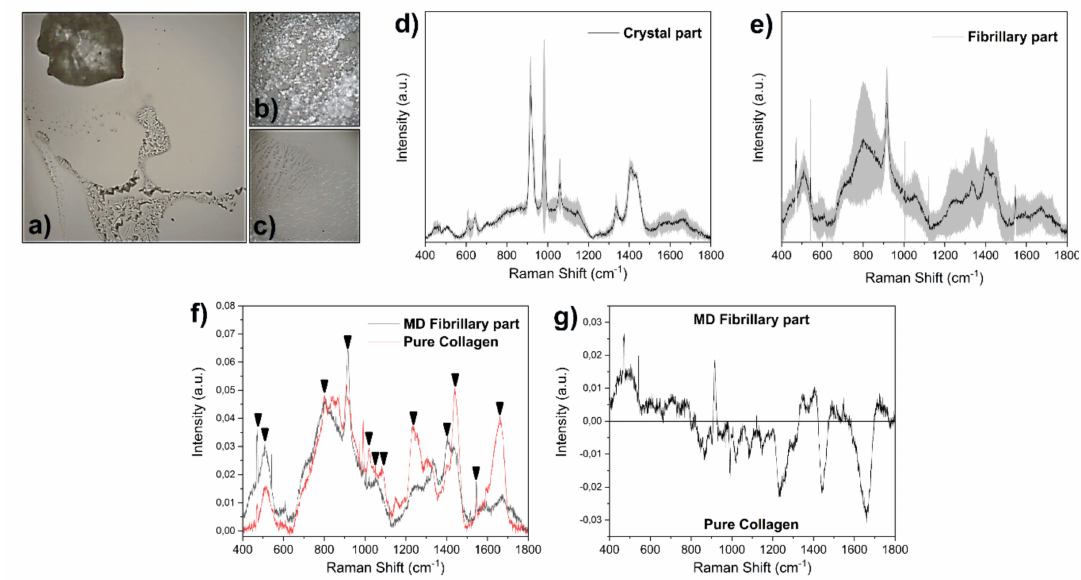
Figure 4. ( a ) Light microscopy micrograph of MD on calcium fluoride (original magnification 50 × ). In the insets, the crystal ( b ) and fibrillary parts ( c ) at higher magnification (100 × ) are shown. Raman signals collected from the ( d ) crystal and ( e ) fibrillary parts. The gray bands represent the associated standard deviation. ( f ) Comparison between pure collagen and MD fibrillary part, with peaks of interest highlighted by the black arrows. ( g ) Subtraction spectrum of MD fibrillary part and pure collagen obtained with the error propagation.